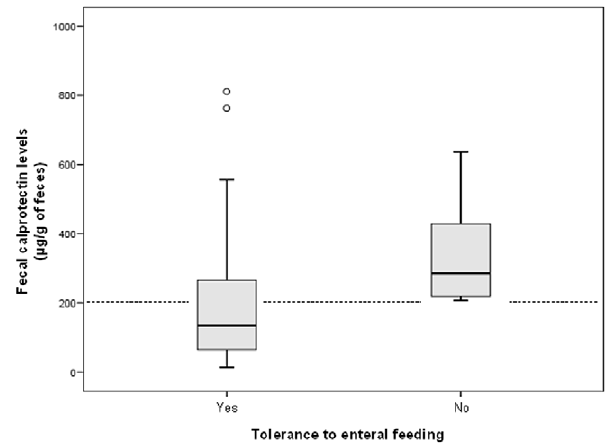
Figure 2. Fecal calprotectin levels in preterm infants without or with poor tolerance to enteral feeding. Fecal calprotectin in preterm infants without poor tolerance to enteral feeding (i.e. with unplanned enteral feeding interruption, n=118), and with poor tolerance to enteral feeding (i.e. with unplanned enteral feeding interruption, n=7). The boxplot shows the median (central horizontal line) and includes the 25 th (lower box border) to 75 th percentile (upper box border). Dotted line represents cut-off level (205 m g/g of feces) for poor tolerance to enteral feeding (see text for details).